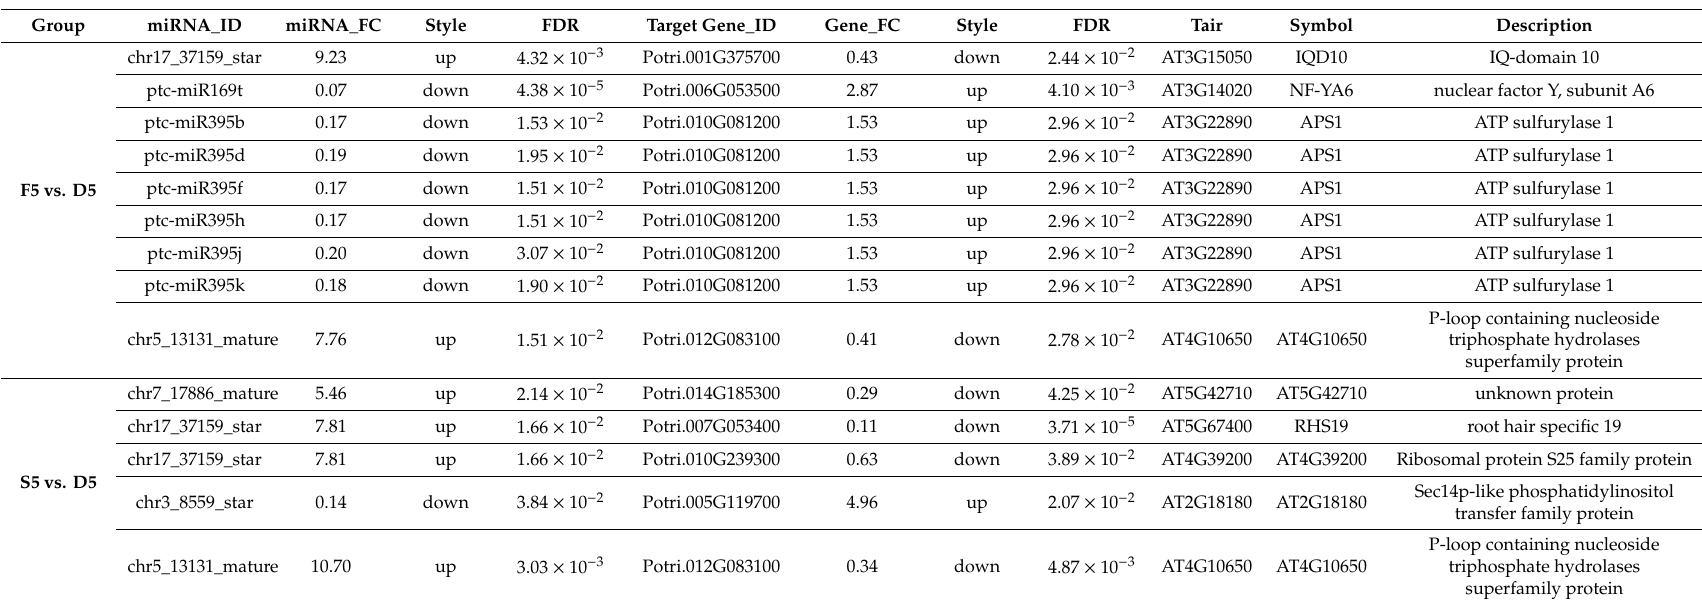
Table 2. Targeted negative regulation relationship in